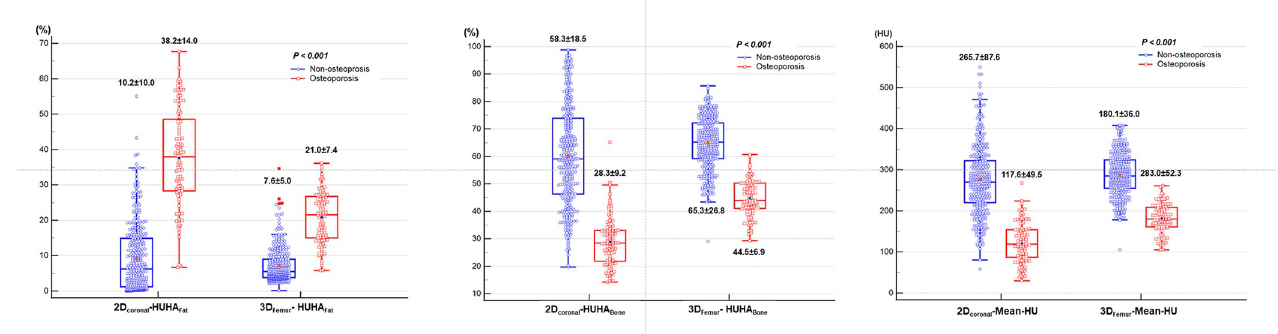
Fig 4. Box plots of HUHA Fat (%), HUHA Bone (%) and mean-HU between osteoporosis and non-osteoporosis. The line in each box represents the median, and the horizontal boundaries of the boxes represent the first and third quartiles. The vertical error bars show the minimum and maximum values (range).